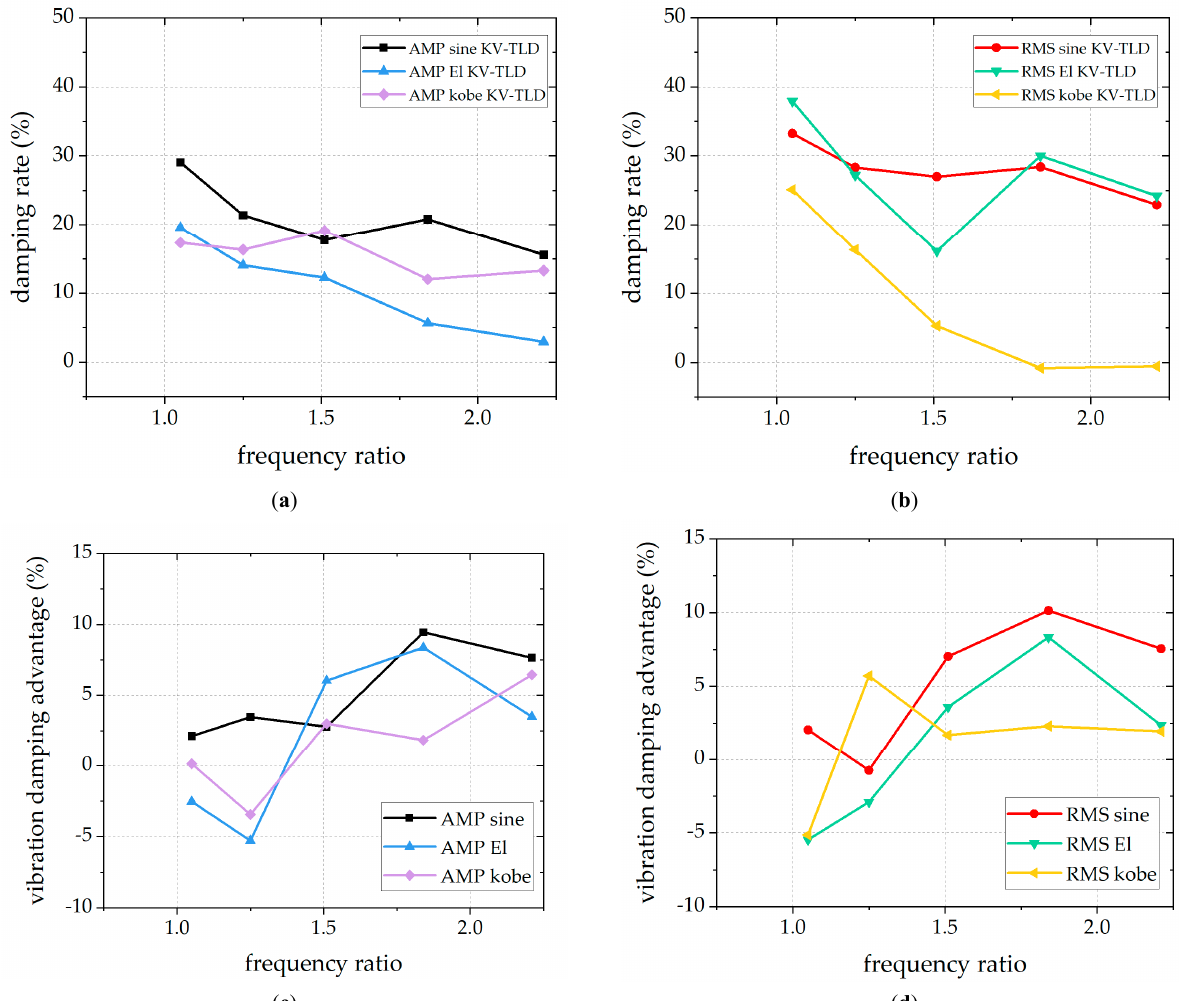
Figure 8. Frequency ratio analysis: mass ratio (4%): ( a ) Damping rate (AMP); ( b ) Damping rate (RMS); ( c ) Vibration damping advantage (AMP); ( d ) Vibration damping advantage (RMS).